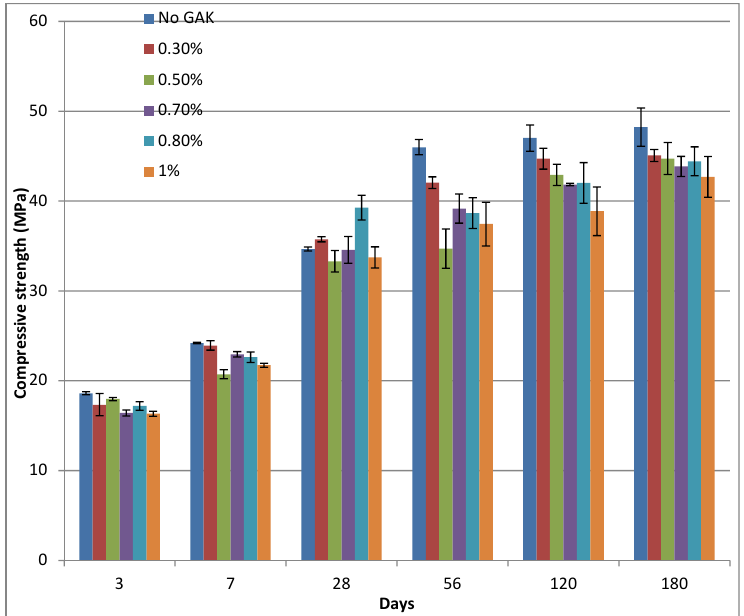
Figure 6. Compressive strength of concrete with different dosages of GAK and a water-binderratio (w/b) = 0.6.